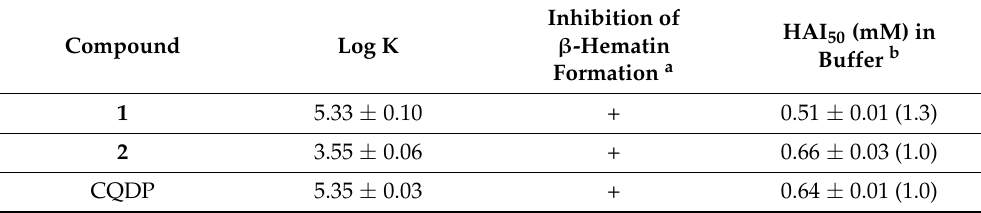
Table 2. Association constants (LogK) of copper-CQ complexes and CQDP with hemin, and charac- teristics of inhibition of β -hematin